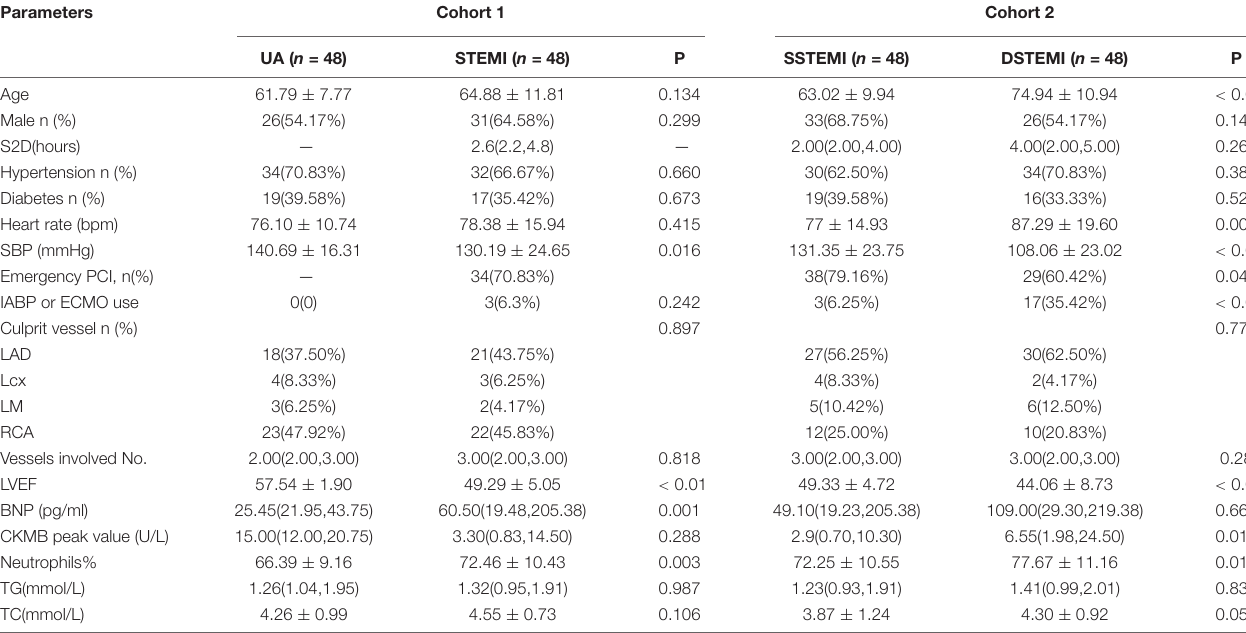
TABLE 1 | Comparison of baseline characteristics.